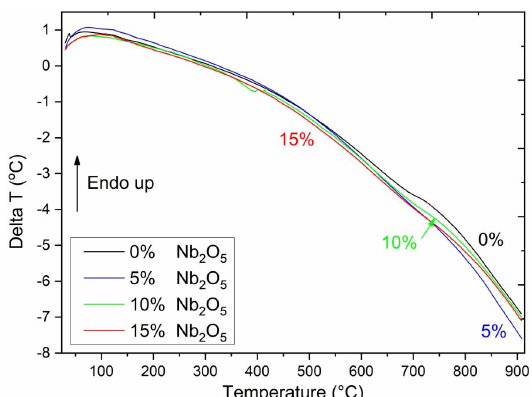
Figure 1. Differential thermal analysis curves of green bodies with and without the addition of Nb 10, and 15